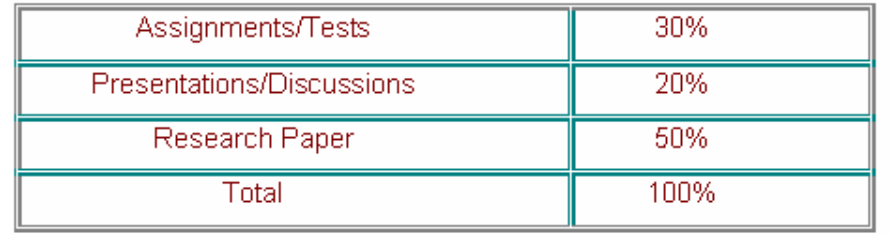
Table 1. Assessment Criteria for “Issues and Trends in Early Childhood